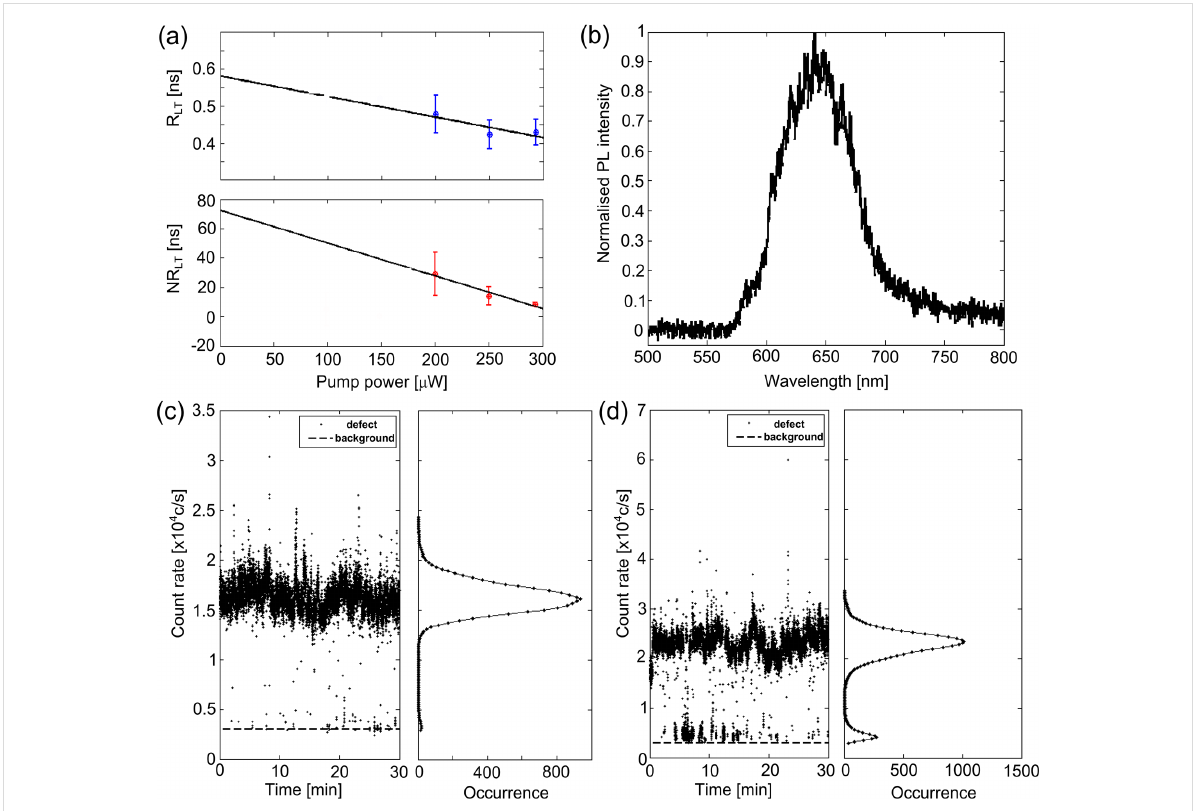
Figure 5: Characterisation results of defect D 2 . (a) The excited-state (R LT ) and non-radiative (NR LT ) lifetimes calculated using a three-level model (with 95% confidence intervals in the uncertainty bars). The black line represents a linear fit for the intrinsic lifetimes using pump powers of 200, 250 and 293 μ W. (b) Normalised PL intensity. The time traces and histograms at pump powers: (c) 99 ± 0.5 μ W (histogram binned into 308 c/s), (d) 148 ± 0.5 μ W (histogram binned into 533 c/s). The dashed line represents the background count rate of 3 × 10 3